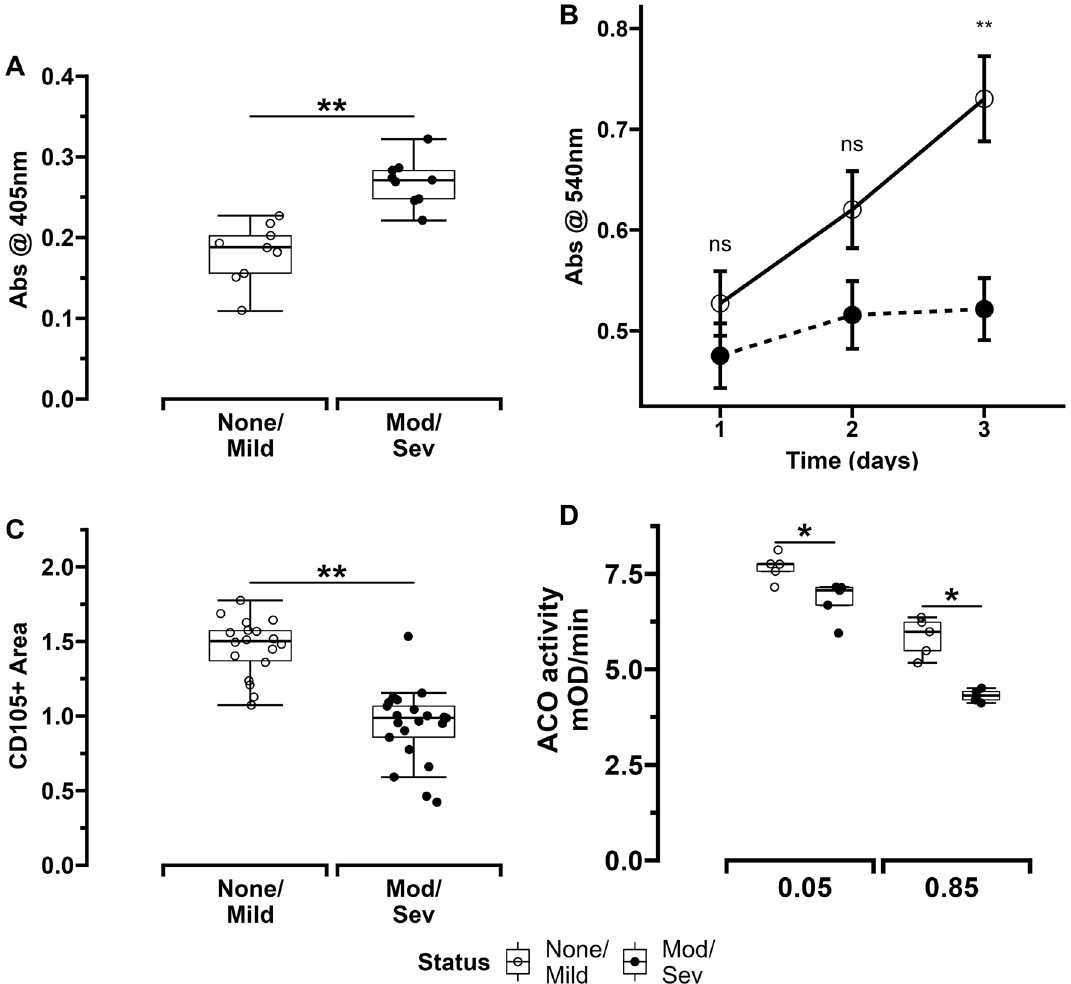
Figure 6. Panel showing MSC survival, proliferation and aconitase activity in ELBW infants. ( A ) MSC apoptosis rates (n = 10 per group). ( B ) MSC proliferation rates measured in cell culture over 3 days (n = 10 per group). ( C ) Quantitative analysis of surface area of umbilical cord sections occupied by MSCs PINK1 protein and RNA expression respectively (n = 10 per group). ( D ) Aconitase activity of MSCs exposed to normoxia (5%) or hyperoxia (85%). n = 5 per group. Differences were analyzed using Mann–Whitney U-test and data expressed as median [25th–75th centiles]. * and ** represent p value < 0.05 and < 0.005 respectively. NS —no significant